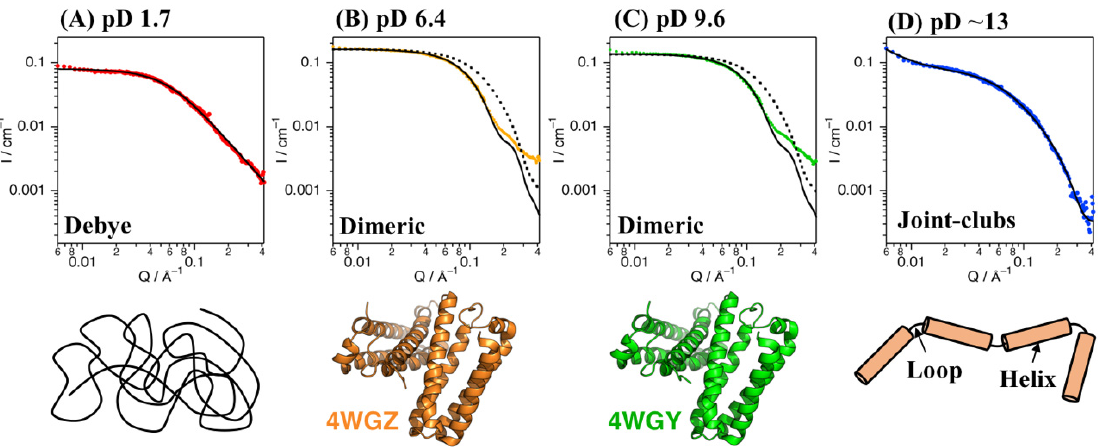
Figure 2. SANS data for Cyt c’ at pD 1.7 ( A , red), 6.4 ( B , orange), 9.6 ( C , green), and ~13 ( D , blue). The black solid lines represent the simulated SANS profiles for Cyt c’. Fitting of the Debye function and joint-clubs model are shown with the SANS curves at pD 1.7 and ~13, respectively. The simulated SANS curves obtained from the dimer (solid line) and monomer (broken line) crystal structures of Cyt c’ at pH 6.0 and 10.4 are shown in panels ( B , C ), respectively. Schematic representation of the random coil ( A ), folded dimer ( B , C ), and open-bundle ( D ) structures of Cyt c’ are provided under the respective SANS curves.